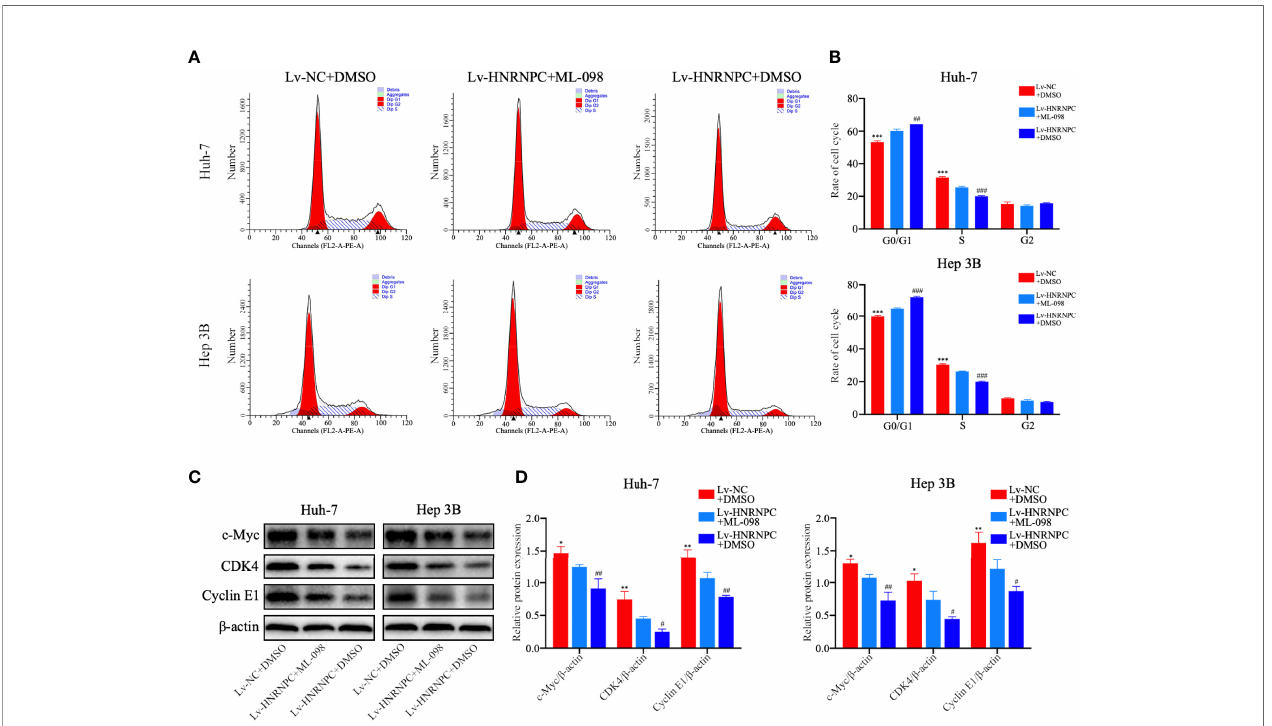
FIGURE 6 | ML-098 partly reversed the reduction in numbers of S phase cells in the Lv-HNRNPC group. (A, B) Cell cycle analysis to detect the recovery of numbers of S phase cells in the Lv-HNRNPC groups after treatment with ML-098. (C, D) Western blot to detect the recovery of c-Myc, CDK4, and cyclin E1 in Lv- HNRNPC cell groups after treatment with ML-098. All tests were repeated independently in triplicate, and the results were showed as mean ± standard deviation (SD). *P < 0.05, **P < 0.01, ***P < 0.001, for Lv-NC+DMSO group compared with Lv-HNRNPC+ML-098 group; # P < 0.05, ## P < 0.01, ### P < 0.001, for Lv- HNRNPC+DMSO group compared with Lv-HNRNPC+ML-098